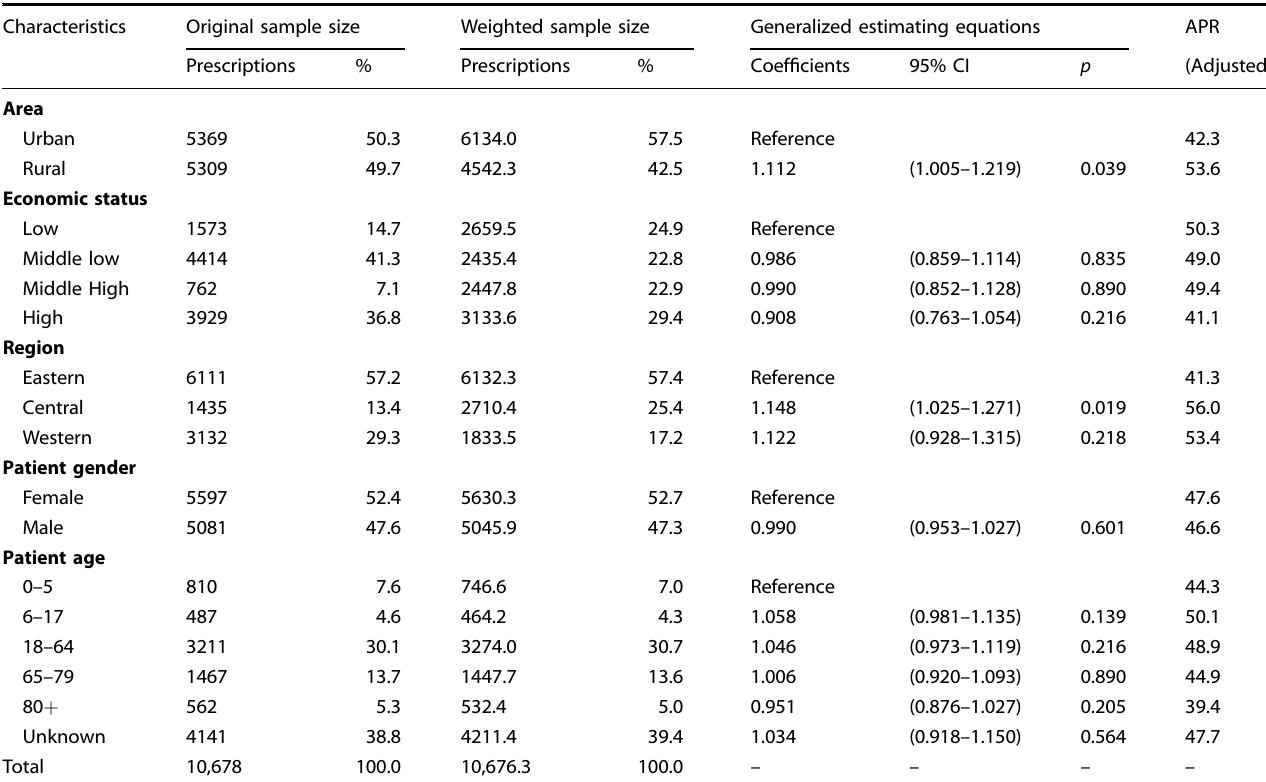
Table 1. Characteristics and antibiotic use for acute bronchitis at primary healthcare facilities in China.